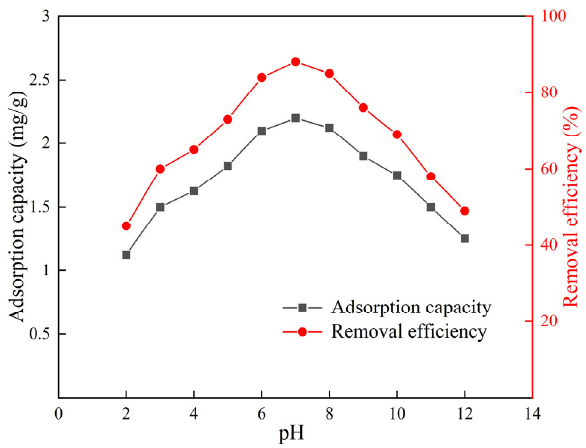
Figure 8. Impact of pH on adsorption of ammonia nitrogen by NaOH ‐